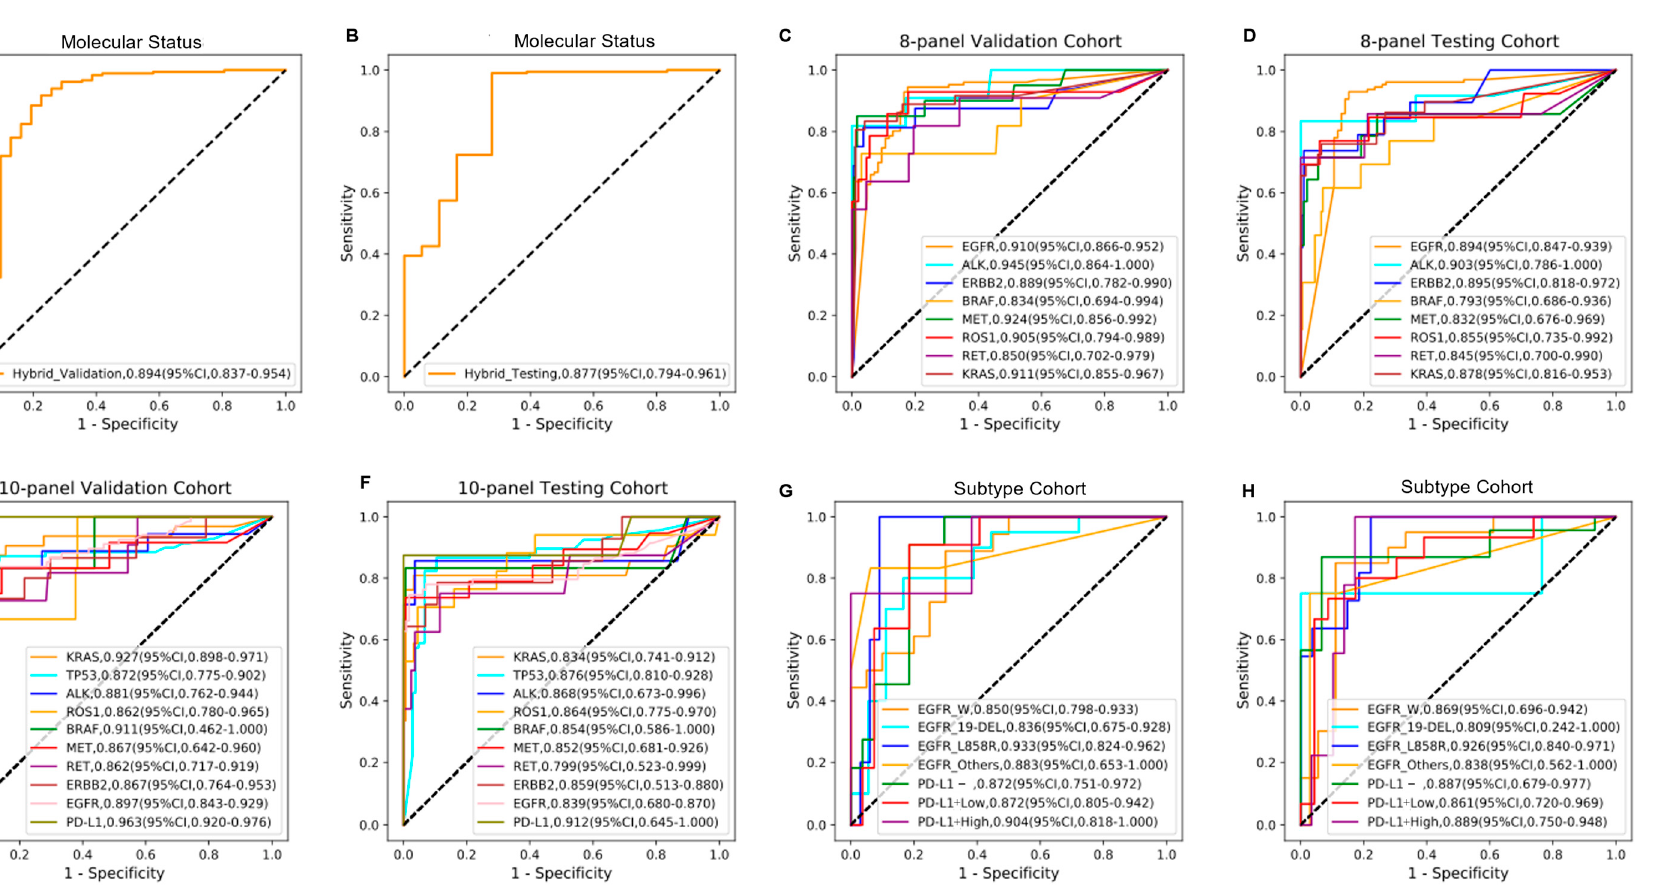
Figure 4. MMDL hybrid model performances in the prediction of multiple molecular alterations. ( A , B ) The ROC curves for predicting target molecular status (positive and negative) in the validation set and testing set, respectively. ( C , D ) The ROC curves for predicting multiple mutations in the 8-panel cohort in the validation set and testing set, respectively. ( E , F ) The ROC curves for predicting multiple alterations in the 10-panel cohort in the validation set and testing set, respectively. ( G , H ) The ROC curves for predicting molecular expression in the subtype cohort in the validation set and testing set, respectively, EGFR _W and PD-L1- represent wild type of EGFR and negative expression of PD-L1. PD-L1+ was separated into PD-L1+ Low and PD-L1+ High according to the TPS cutoff of